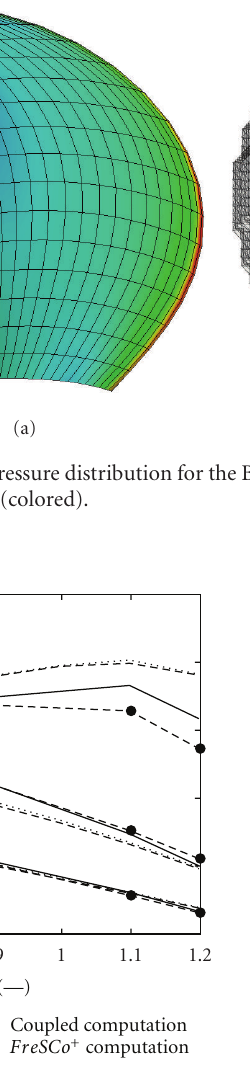
Figure 14: Comparison of predicted and measured open-water results for the investigated propeller.